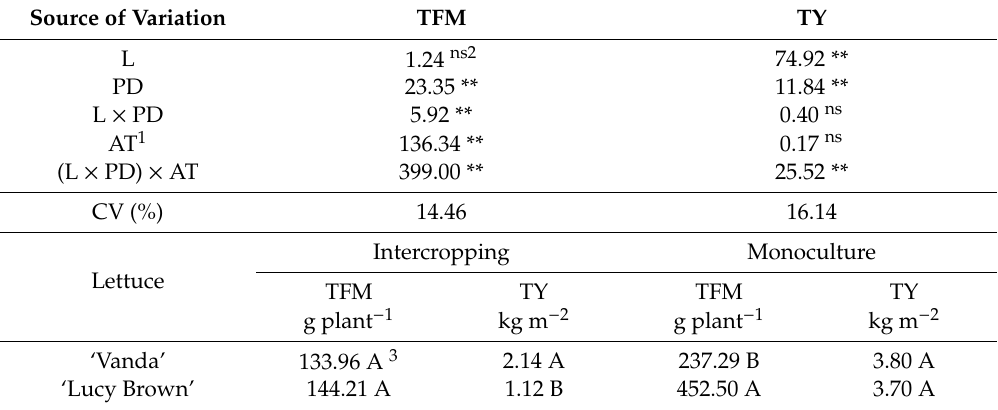
Table 3. Variance analysis for total fresh mass (TFM) and total yield (TY) in lettuces ‘Vanda’ and ‘Lucy Brown’ as a function of lettuce (L) cultivars and cucumber population density